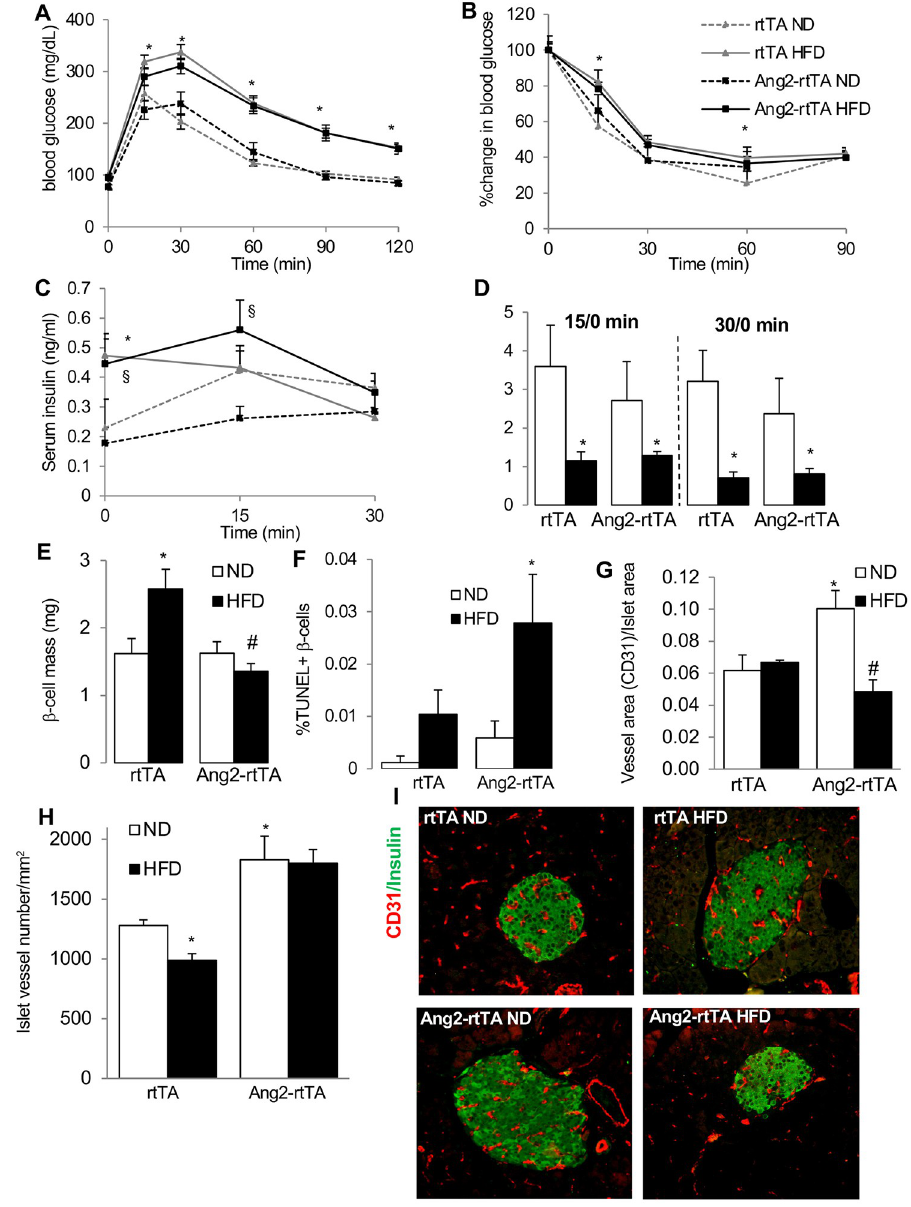
Fig 4. Ang-2 over-expression leads to islet hypovascularization and β -cell failure in response to HFD. β -cell specific overexpressing male Rip-rtTA;tet-O-Ang-2 (Ang2-rtTA) and Rip-rtTA (rtTA) kept on a normal diet (ND) or high-fat high-sucrose diet (HFD) received 1mg/ml doxycycline in drinking water for 16 weeks. (A,B) Blood glucose levels from intraperitoneal glucose (A) and insulin tolerance (B) tests performed at 16 weeks of HFD. (C,D) Glucose stimulated insulin secretion, showing levels of serum insulin and stimulatory index at 15 and 30 min after glucose injection. Data are means +/-SE from 4 independent experiments from n = 8 (ND) or n = 19 mice/group. (E-H) Pancreatic sections were analysed for (E) β -cell mass (F) apoptosis by double staining for TUNEL and insulin (10,000 β -cells/mouse, n = 6 mice/group) and (G) islet vessel area quantified by CD31/ Insulin co-staining (100 islets/mouse, n = 6 mice/group). (H) Islet vessel density from 3 animals per group represented as number of vessels per islet-mm2 (I) Representative images from CD31 (red)/Insulin (green) co-staining. � p < 0.05 vs. rtTA ND, # p < 0.05 vs. rtTA HFD, § p < 0.05 vs. Ang2-rtTA